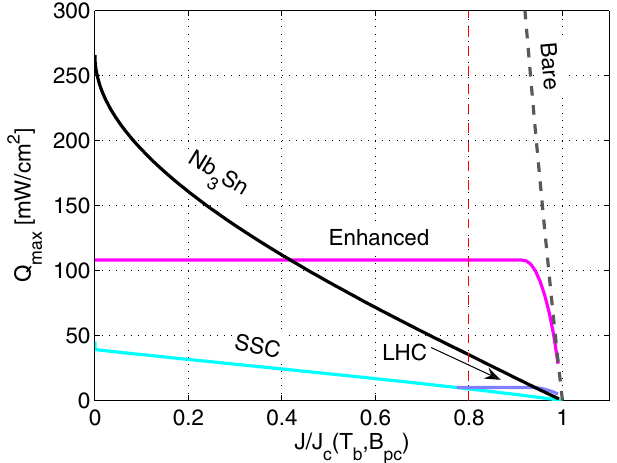
FIG. 9. (Color) Maximum heat flux from Nb-Ti (with insulation: LHC, SSC, enhanced; and without insulation: bare) and Nb coils versus operative over critical current density ratio. Comparison for specific operating conditions, Nb-Ti: 9 T; Sn : 13.5 Nb 3